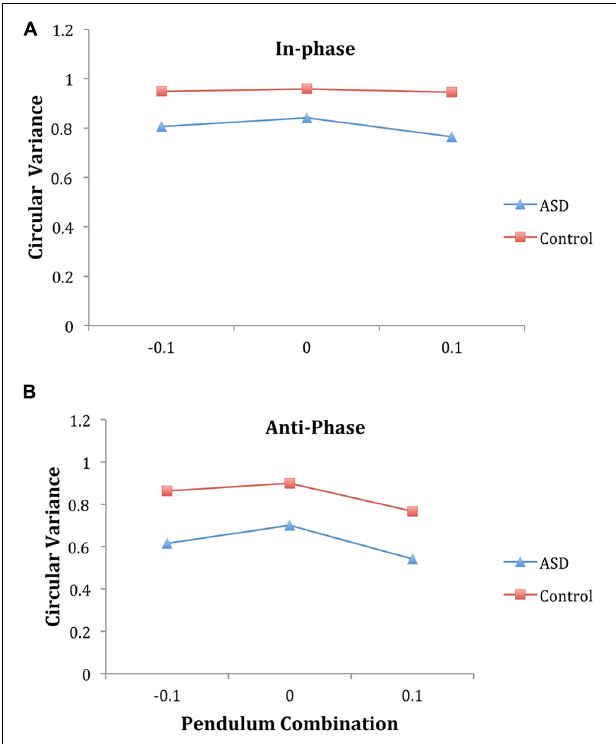
FIGURE 3 | Intentional coordination phase entrainment (as indexed by circular variance of relative phase) supports the dynamical model predictions. Namely, entrainment is lower for anti-phase (B) than in-phase (A) and entrainment is higher for similar pendulum combinations than different combinations. Importantly, the ASD pairs had lower overall entrainment than the control pairs in all conditions. (Note: Convention comparable with Varlet et al., 2012; − 0.1 indicates parent should lead, + 0.1 indicates child should lead.)